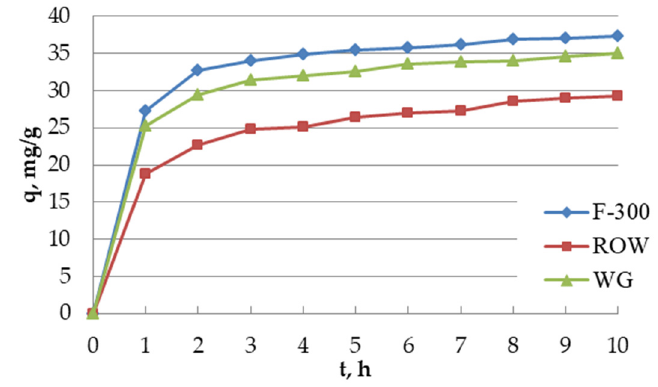
Figure 3. Oxytetracycline adsorption kinetics.